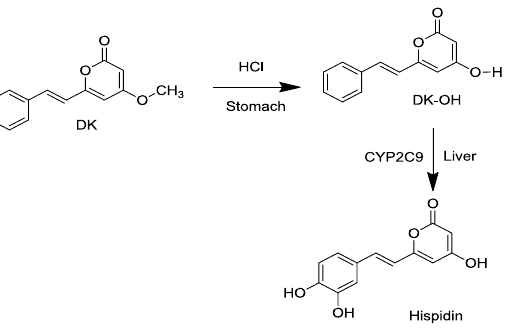
Figure 1. Conversion of 5,6-dehydrokawain (DK) to